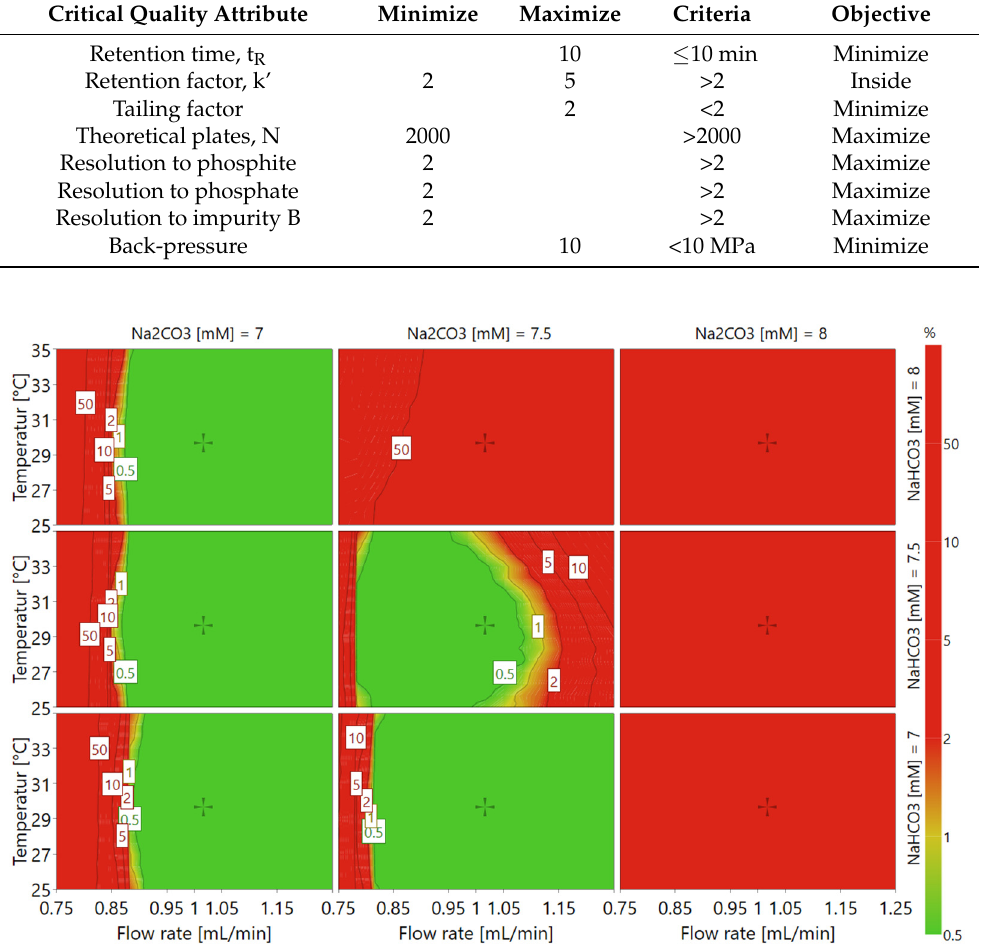
Figure 4. Design space illustrating optimum range of method conditions. The cross mark represents projection of the calculated robust set point. Colors and labels indicate the calculated percent probability of failure. Table 4. Set quality attribute ranges, criteria, and objectives for foscarnet peak characteristics during design space evaluation.